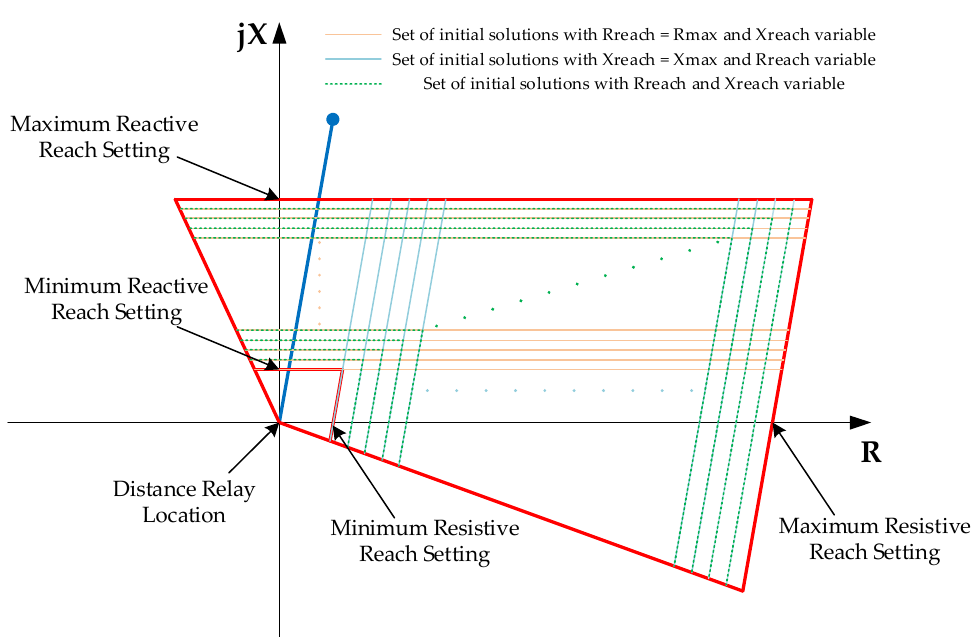
Figure 8. Definition of the initial population according to the setting limits of R and X reaches.